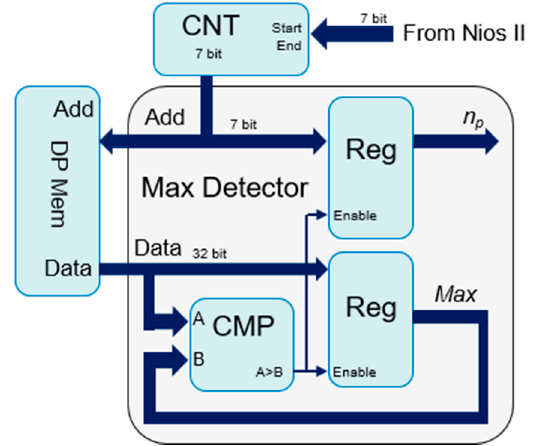
Figure 5. Details of the implementation of the Max Detector. Electronics 2020 , 9 , 456